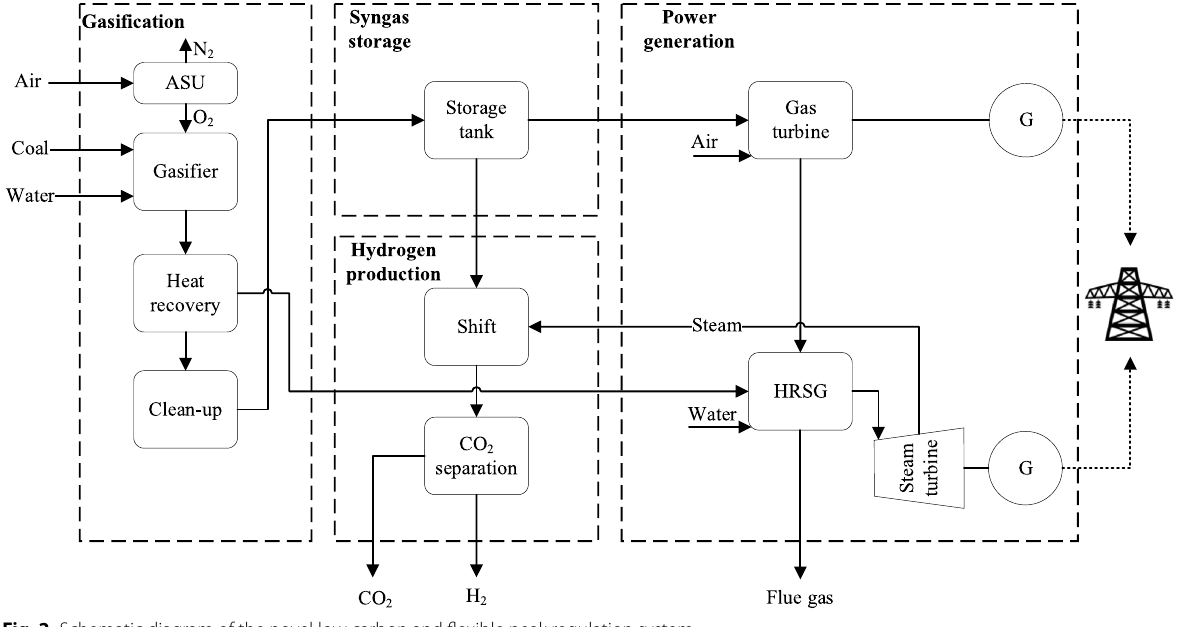
Fig. 2 Schematic diagram of the novel low carbon and flexible peak regulation system